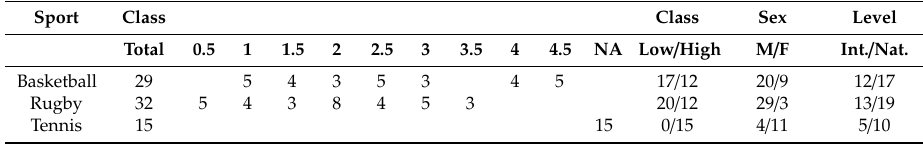
Table 1. Participant characteristics. For the class, additional grouping was applied with a low-class group consisting of class 1–2.5 for wheelchair basketball and 0.5–2 for wheelchair rugby. The high-class group consisted of 3 + for wheelchair basketball, 2.5 + for wheelchair rugby and all athletes for wheelchair tennis.